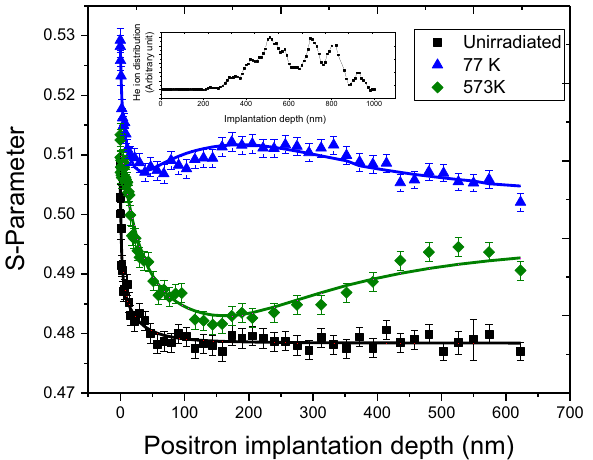
Figure 8. S-E profiles of unirradiated sample and 0.2 dpa samples irradiated at varying irradiation temperatures of 77 K and 573 K. The solid line shows the fitting of S-E profiles using the program